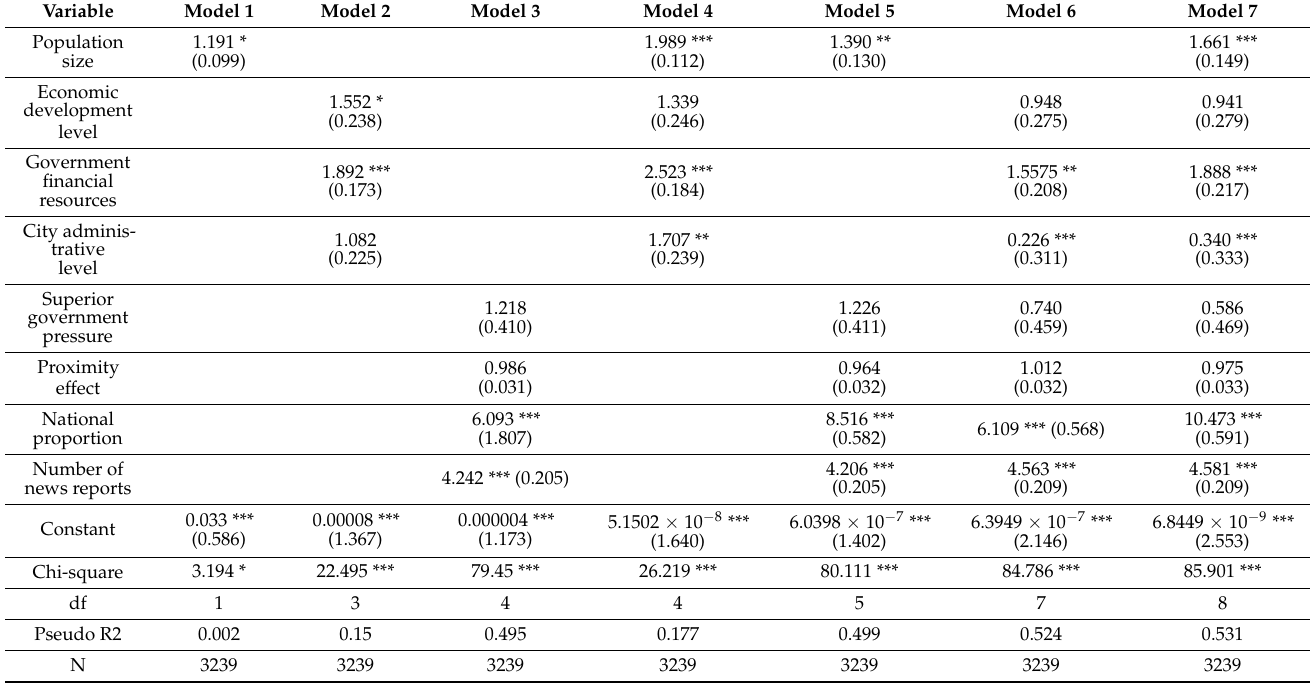
Table 4. Event history analysis (EHA) of PPP policy